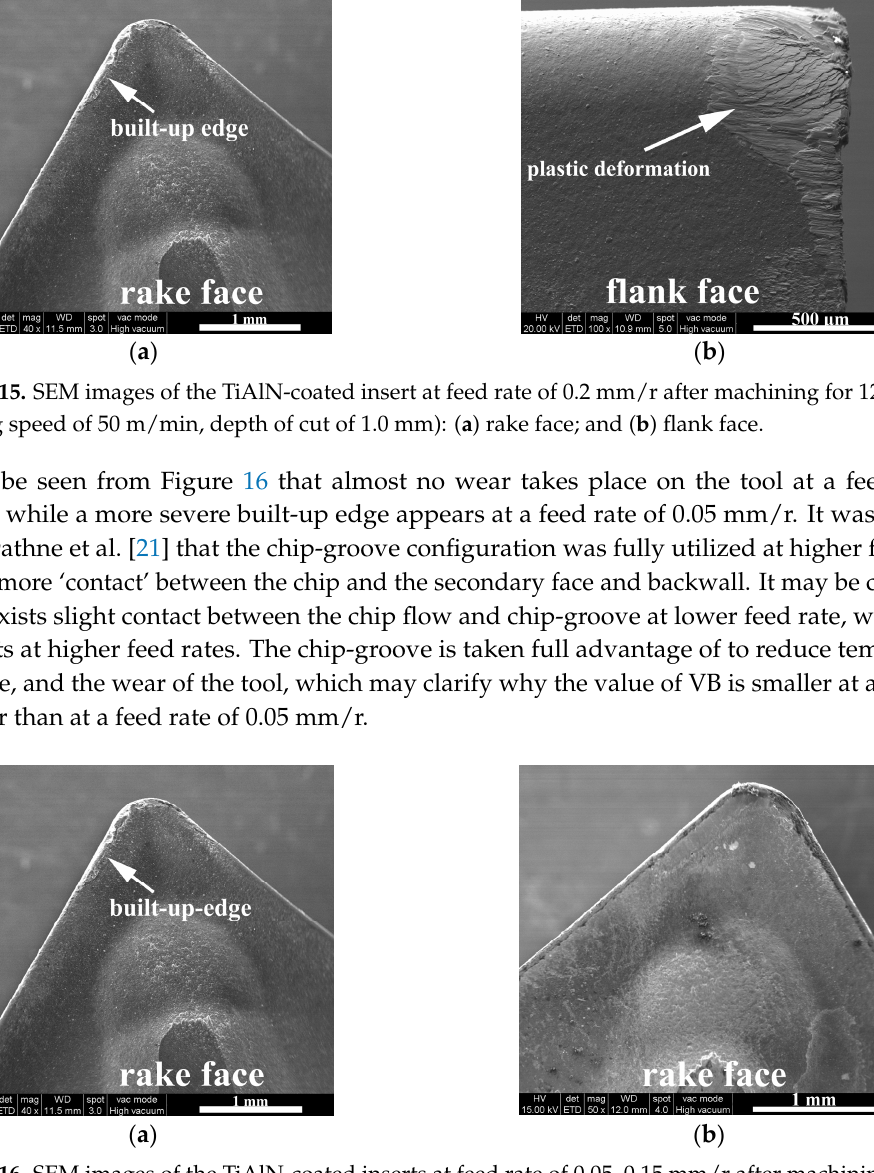
Figure 16. SEM images of the TiAlN-coated inserts at feed rate of 0.05, 0.15 mm/r after machining for 12 min, respectively (cutting speed of 50 m/min, depth of cut of 1.0 mm): ( a ) feed rate of 0.05 mm/r; and ( b ) feed rate of 0.15 mm/r.